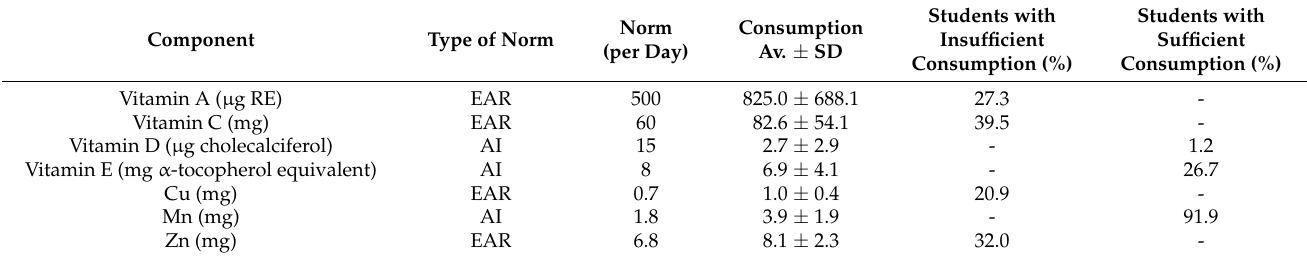
Table 2. Percentage of young women with sufficient and insufficient consumption of the tested antioxidant ingredients.